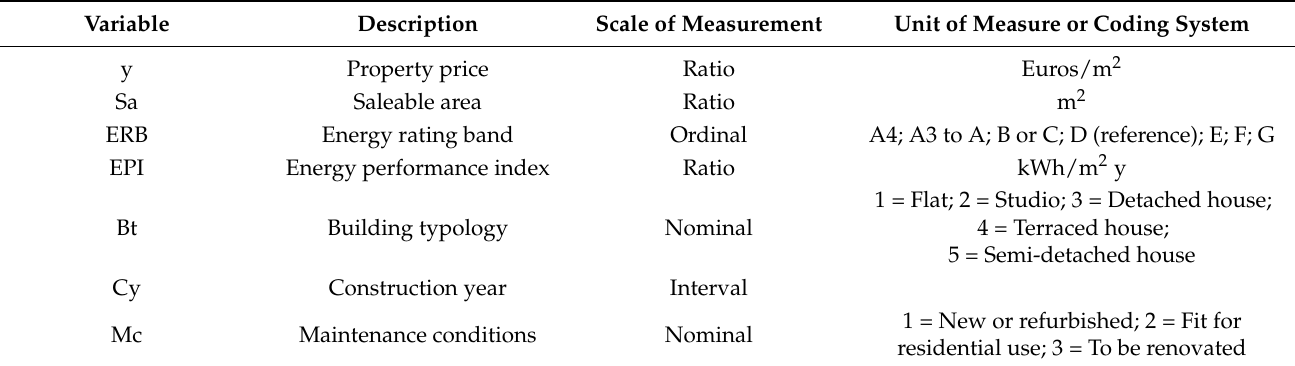
Table 1. List of the variables used for the spatial autoregressive